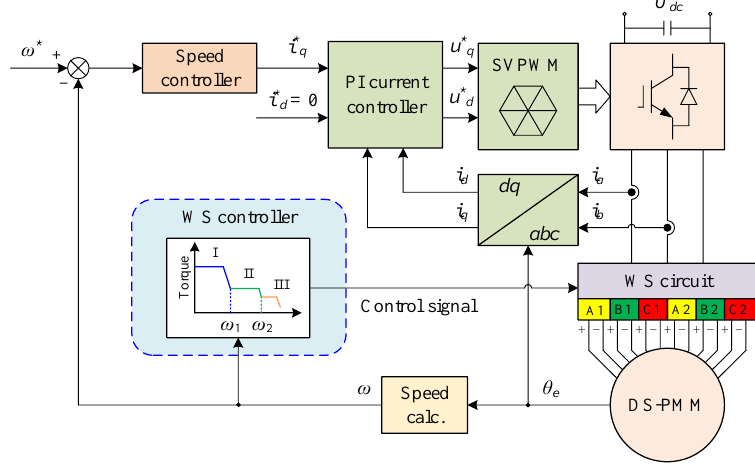
Figure 6. Schematic diagram of the WS strategy for the DS-PMM based on current vector control.